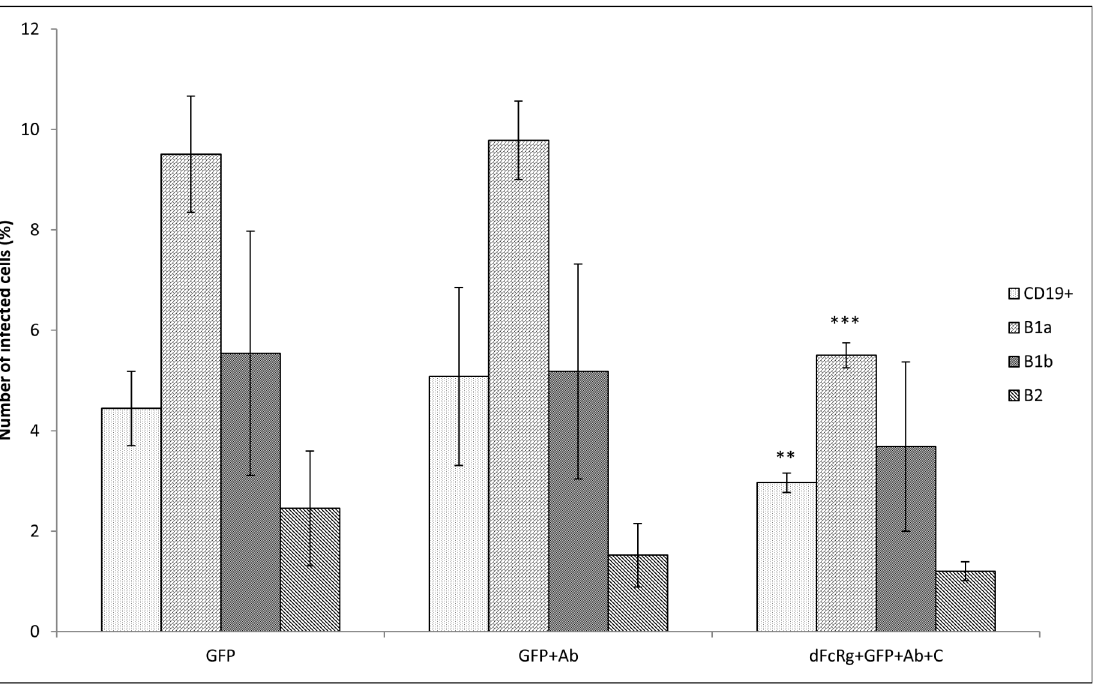
Fig 7. Blocking of Fc γ R. Peritoneal cells were incubated with the antibody against CD16/32 (dFcRg). Thereafter, cells were infected with F . tularensis LVS/ GFP (GFP), F . tularensis LVS/GFP opsonized with antibodies (GFP+Ab), and F . tularensis LVS/GFP opsonized with murine fresh serum and antibodies (dFcRg+GFP+Ab+C) at MOI 500. Entry into all B cells (CD19 + ) and individual B cell subsets was detected 3 h after infection by flow cytometry. Error bars indicate SD around the means of samples processed in triplicate. Two-tailed t -test was used to test for significant differences between GFP and GFP+Ab and between GFP+Ab and dFcRg+GFP+Ab+C ( *** P < 0.001, ** P < 0.01). Results shown from one experiment are representative of three independent experiments